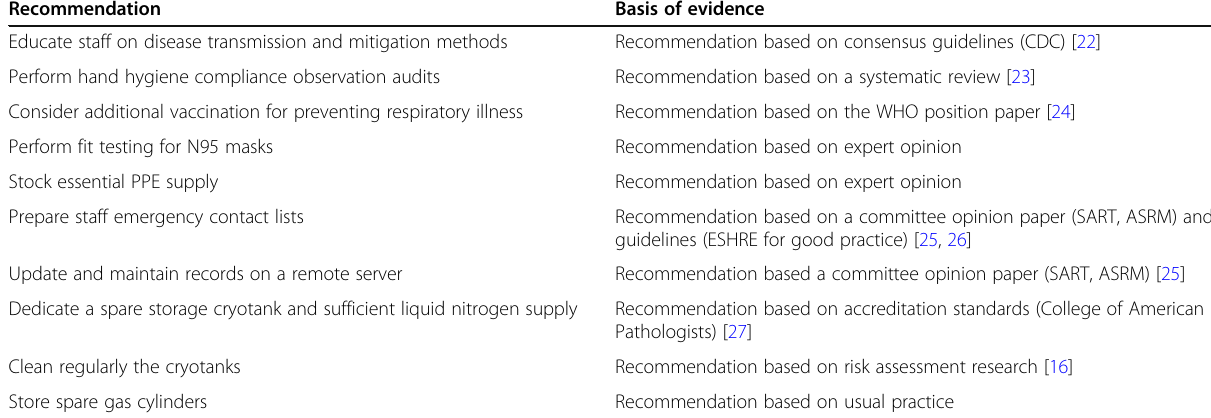
Table 1 Early-level response plan: pre-pandemic planning recommendations for embryology and andrology